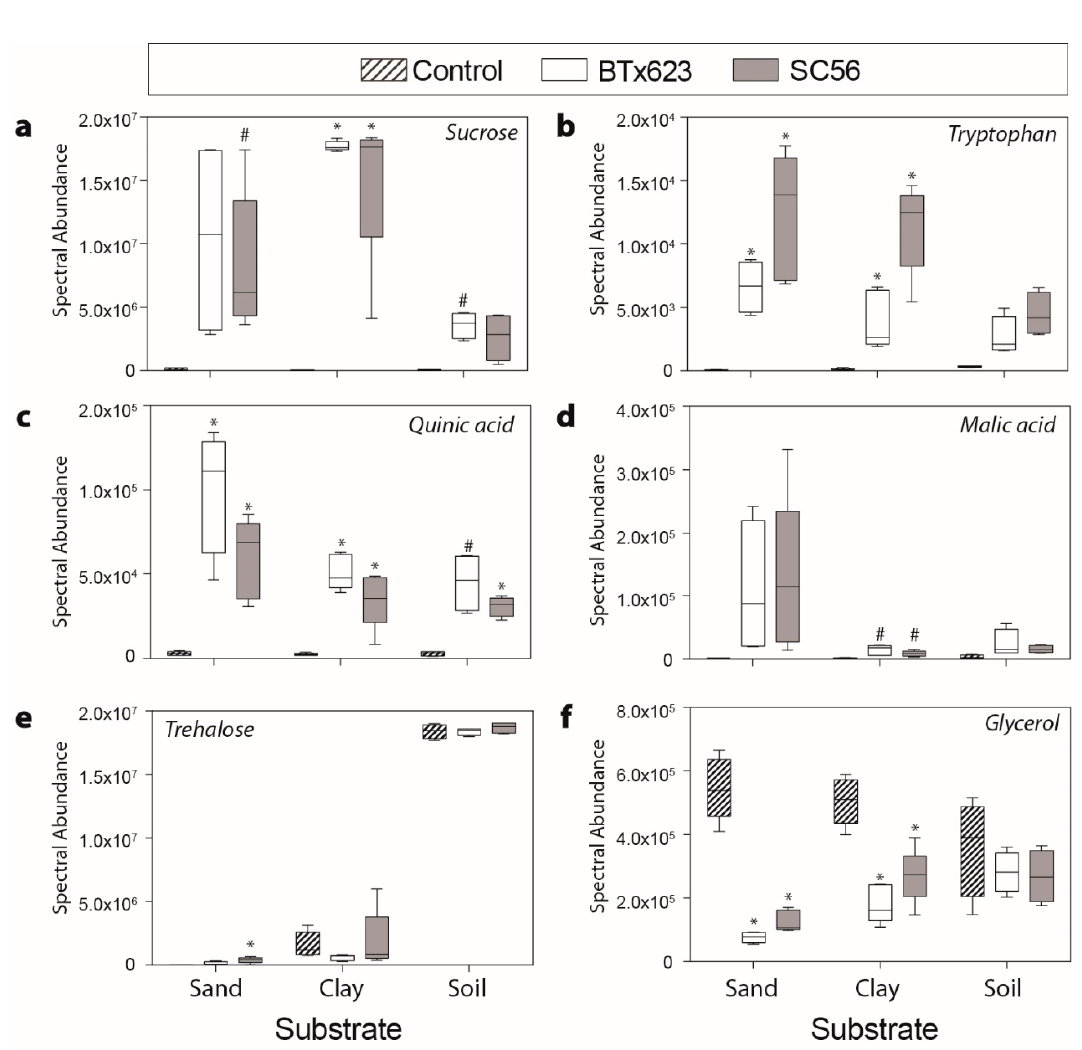
Figure 5. Boxplots of selected metabolites ( a ) sucrose, ( b ) tryptophan, ( c ) quinic acid, ( d ) malic acid, ( e ) trehalose, and ( f ) glycerol within clay, sand, and soil. Asterisk (*) indicates a significant difference between the genotype and control ( p < 0.05) after false discovery rate adjustment; pound sign (#) indicates p < 0.10.